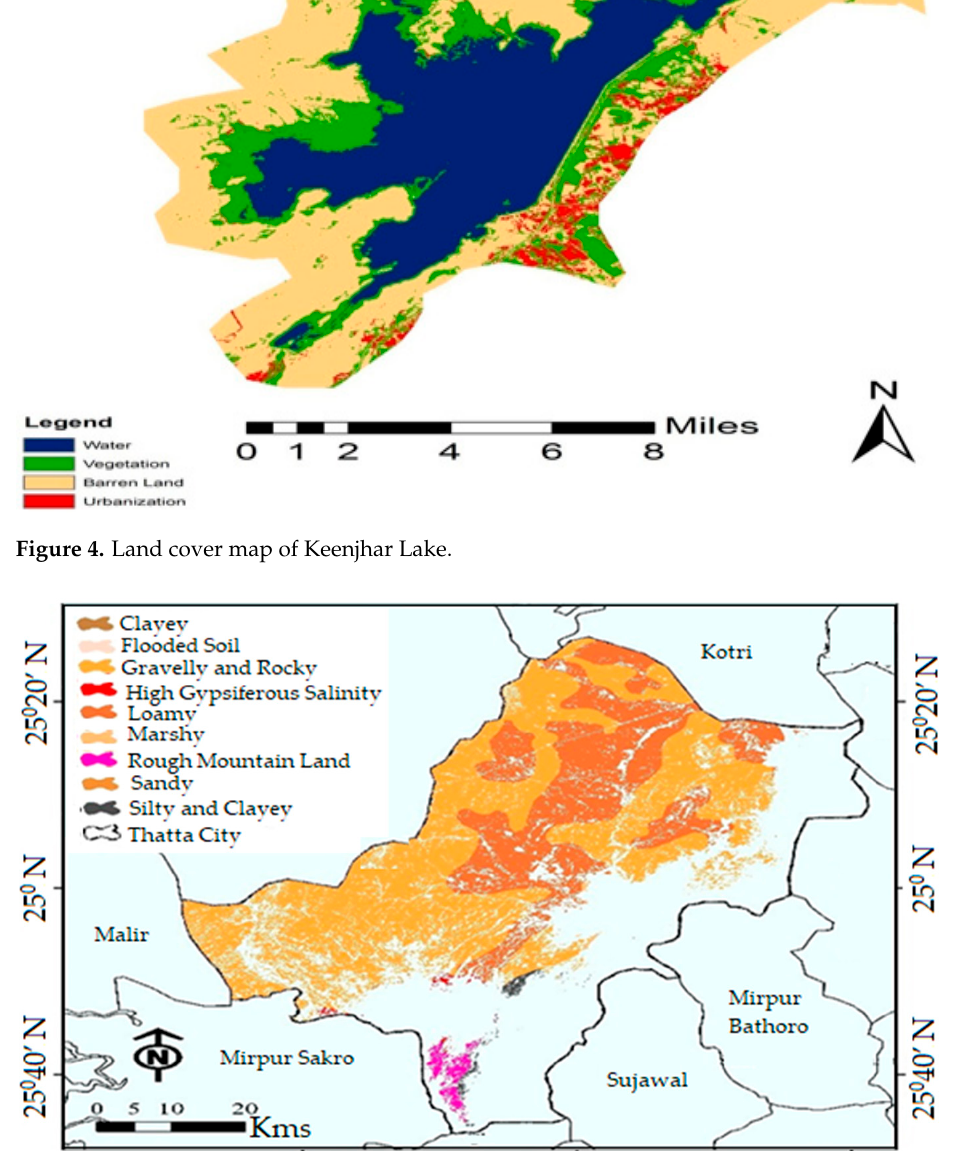
Figure 5. Soil map of the Thatta district [39].